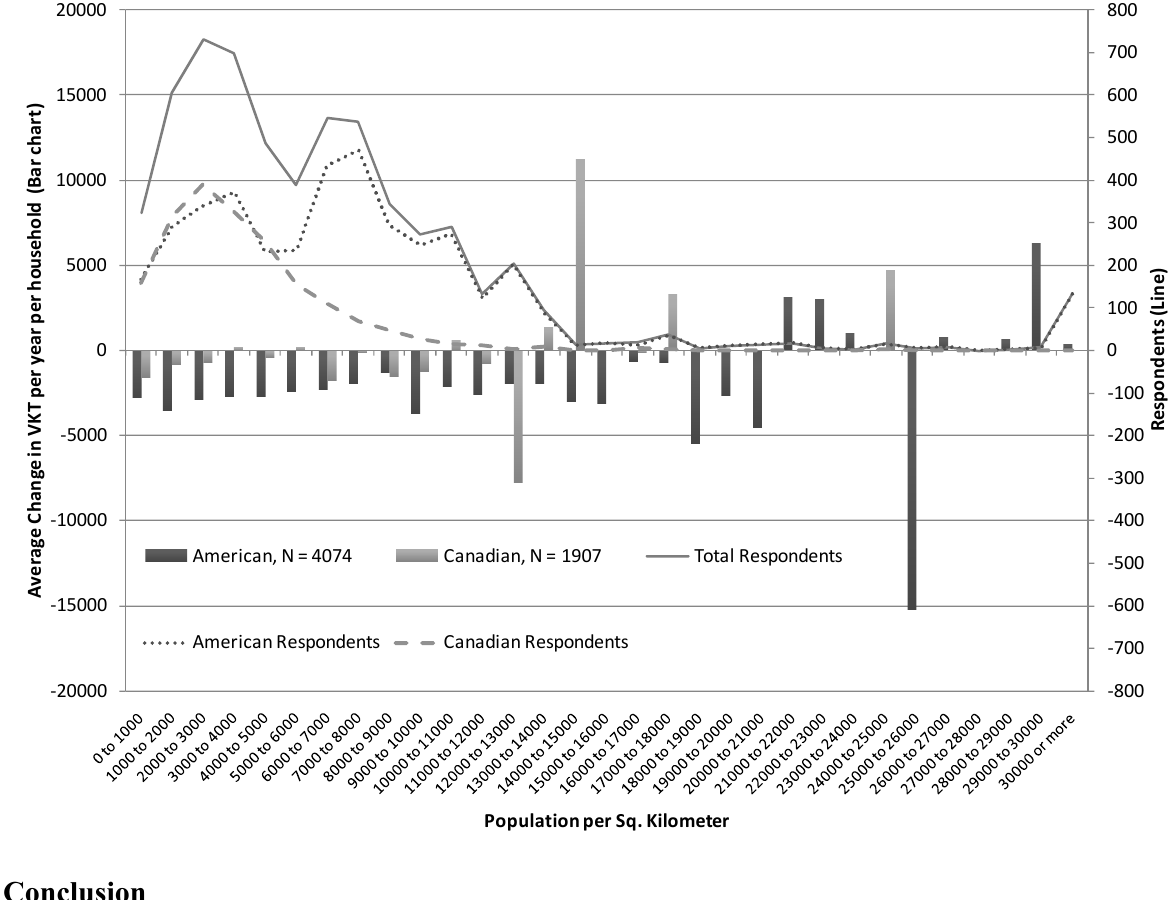
Figure 4. Average VKT Change by Population Density of